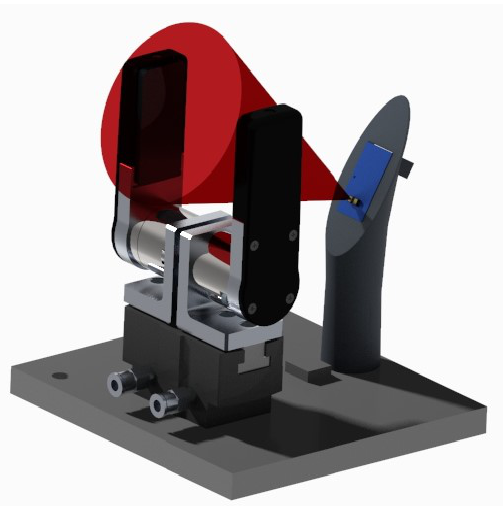
Figure 1. CAD rendering of the experimental setup. The red cone represents the proximity sensor field of